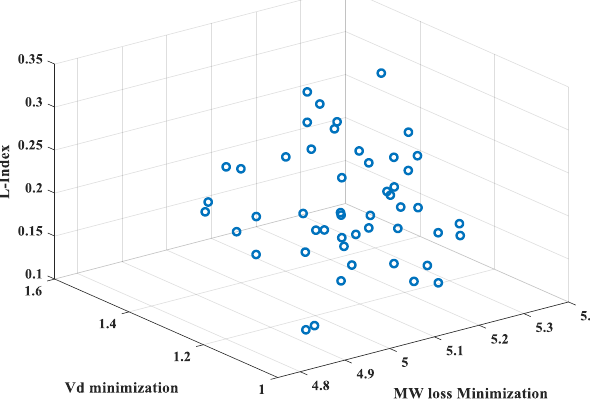
Figure 6. Pareto optimal front for the IEEE 30 test system.